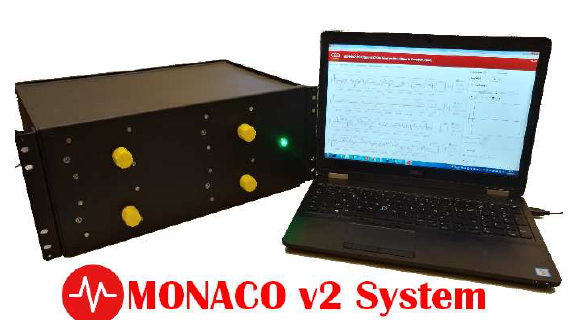
Figure 2: Photograph of the MONACO V2 system